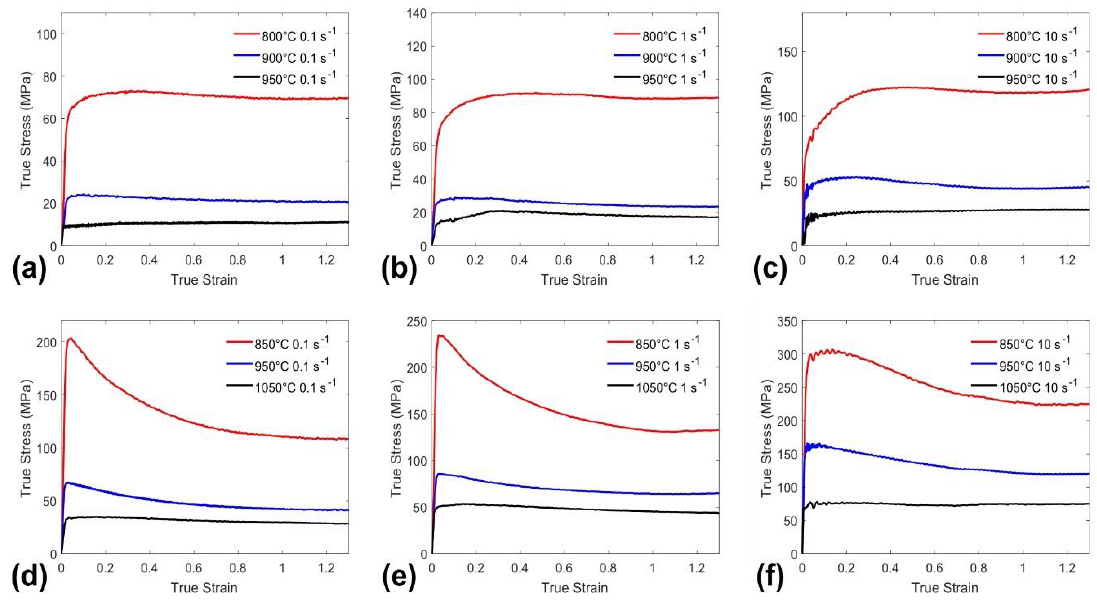
Figure 5. Friction corrected flow stress curves for the full matrix of temperatures of CP-Ti TMC tests at; ( a ) 0.1 s − 1 ; ( b ) 1 s − 1 ; ( c ) 10 s − 1 . Ti-6-4 TMC tests at; ( d ) 0.1 s − 1 ; ( e ) 1 s − 1 ; and ( f ) 10 s − 1 .